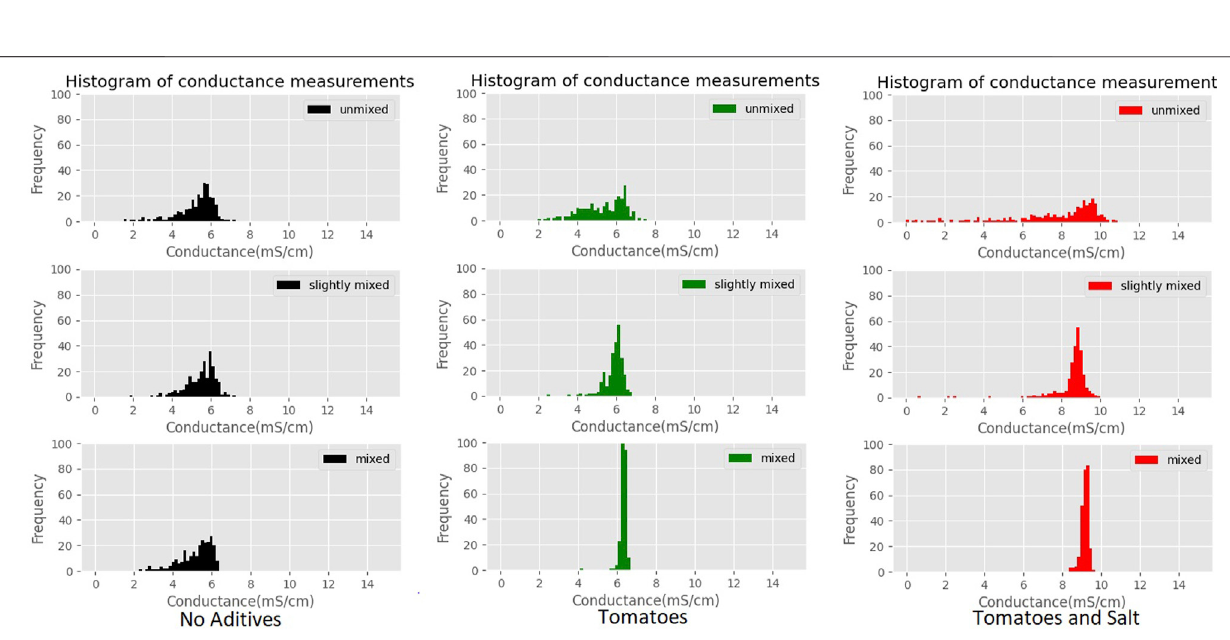
Frontiers in Robotics and AI |